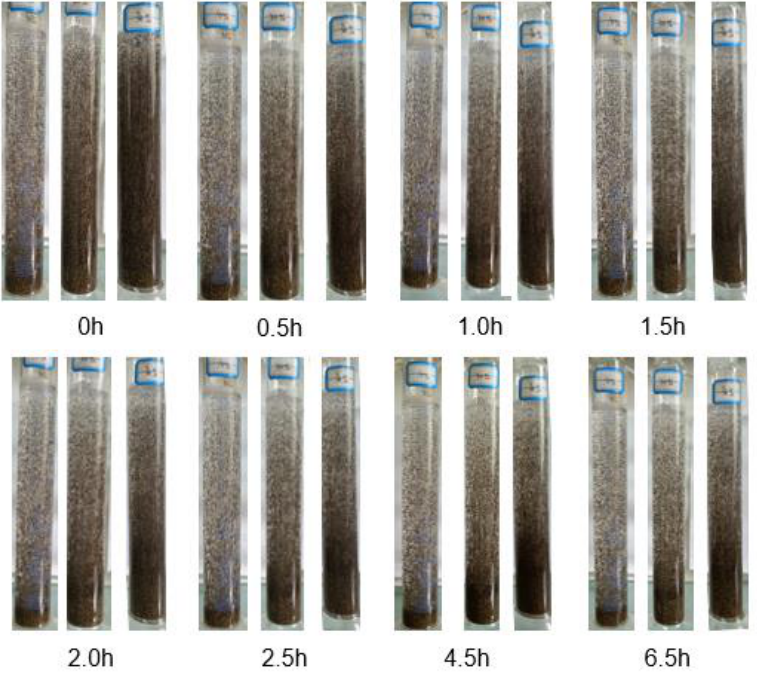
Figure 11. Proppants suspending performance (27 °C, 2% EAPB + 0.5% OAPB + 0.1% KCl).